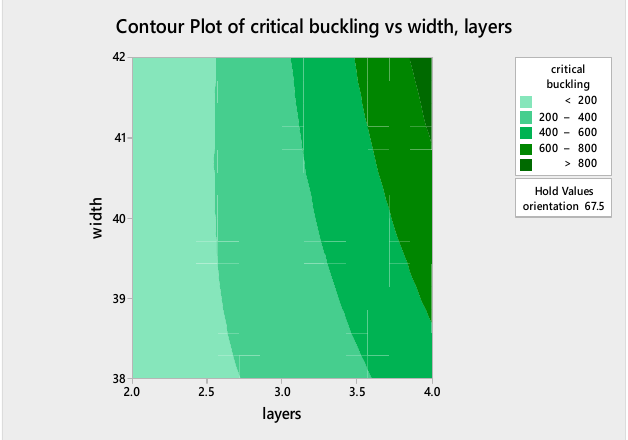
Figure 12. Contour plot of critical buckling versus width, layers.